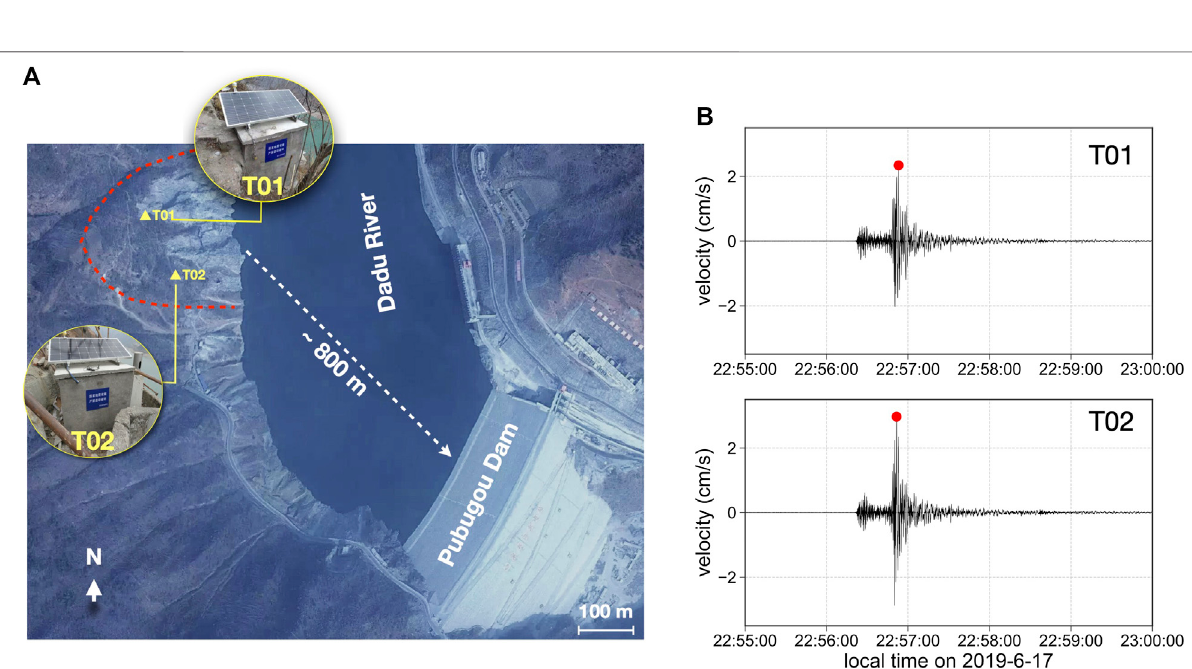
FIGURE 2 | (A) Con fi guration of two seismic stations (yellow triangles) on the slope (the boundary of the slope is delineated by a red dashed line). (B) Peak ground velocity (red circles) due to the Changning Mw 5.7 earthquake recorded for its vertical component by the two stations T01 and T02 on the